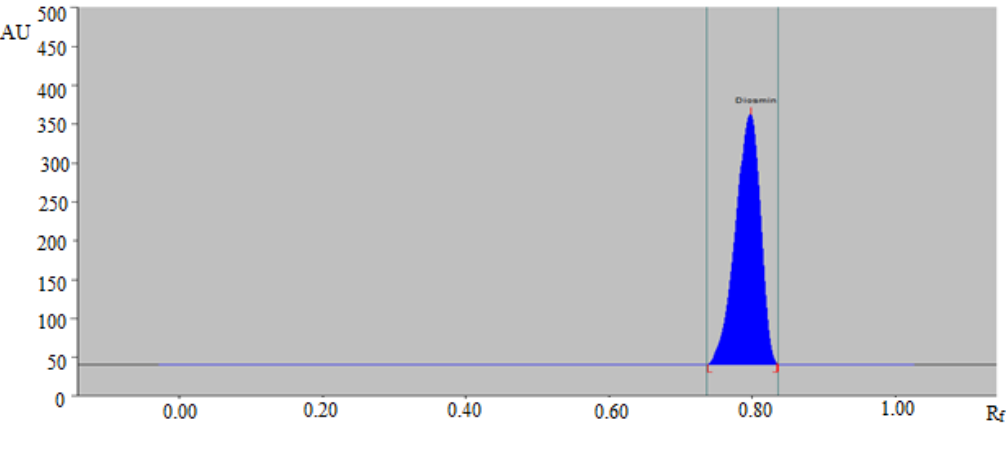
Figure 2. HPTLC-densitogram of standard DIOM.